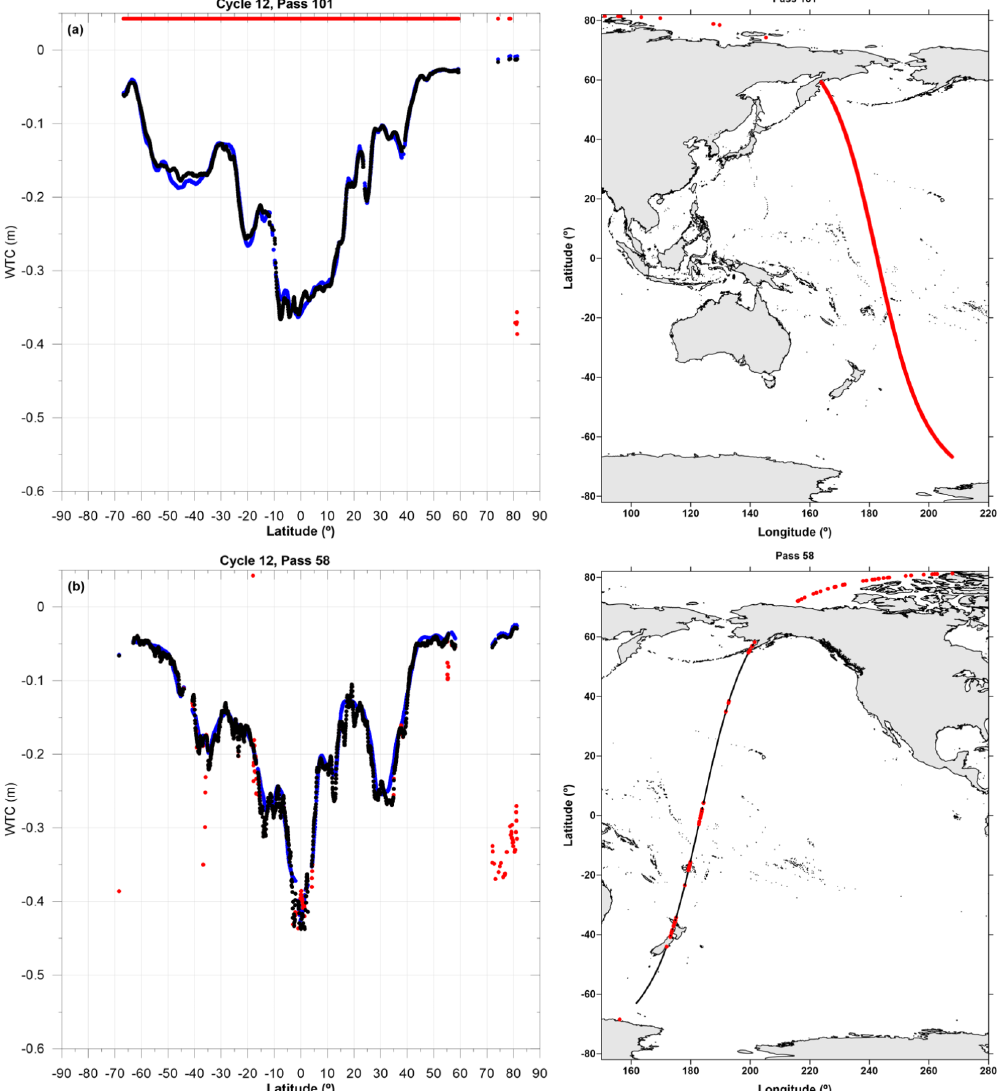
Figure 7. Along-track WTCs (m) present in the Envisat FMR V3.0 products for Envisat cycle 12, passes 101 and 58 (panels a and b , respectively): GPD + (black), MWR-derived WTC (red) and ERA-Interim WTC (blue). Panel (a) shows an example of the unavailability of the on-board MWR-derived WTC; panel (b) shows contamination by ice and rain (red points around the Equator) in the MWR-derived WTC. Right: geographical coverage of the Envisat tracks shown in the left panels (longitude is given in the 0–360 ◦ range to show the entire track). Along-track points with a GPD + estimate are shown in red, while points where the GPD + kept the MWR-derived WTC are shown in